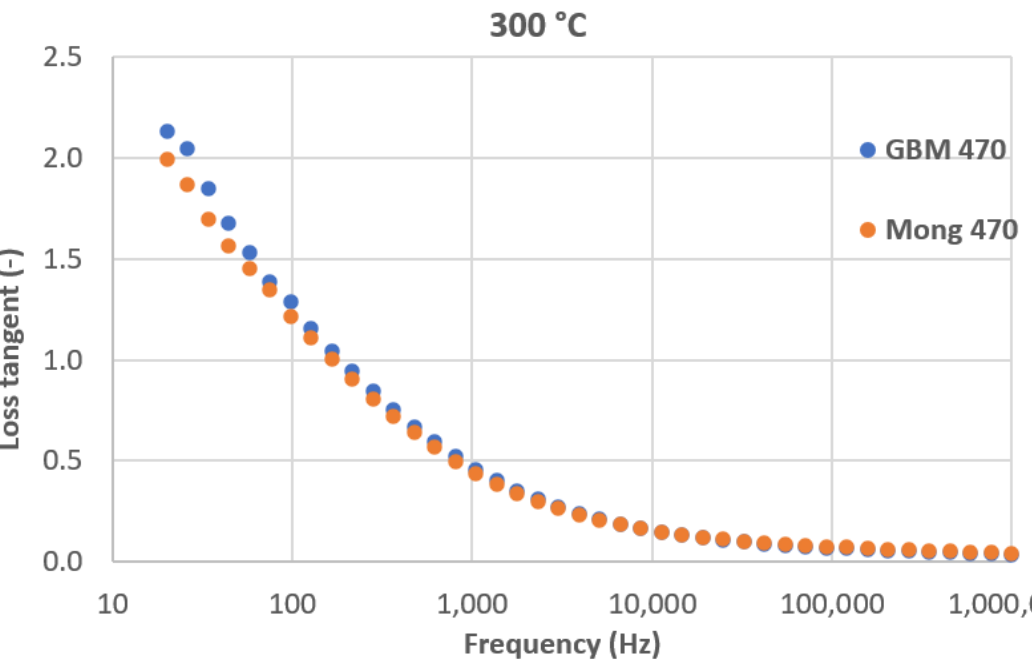
Figure 15. Loss tangent dependence on frequency at 300 °C for coatings sprayed with SD 370.